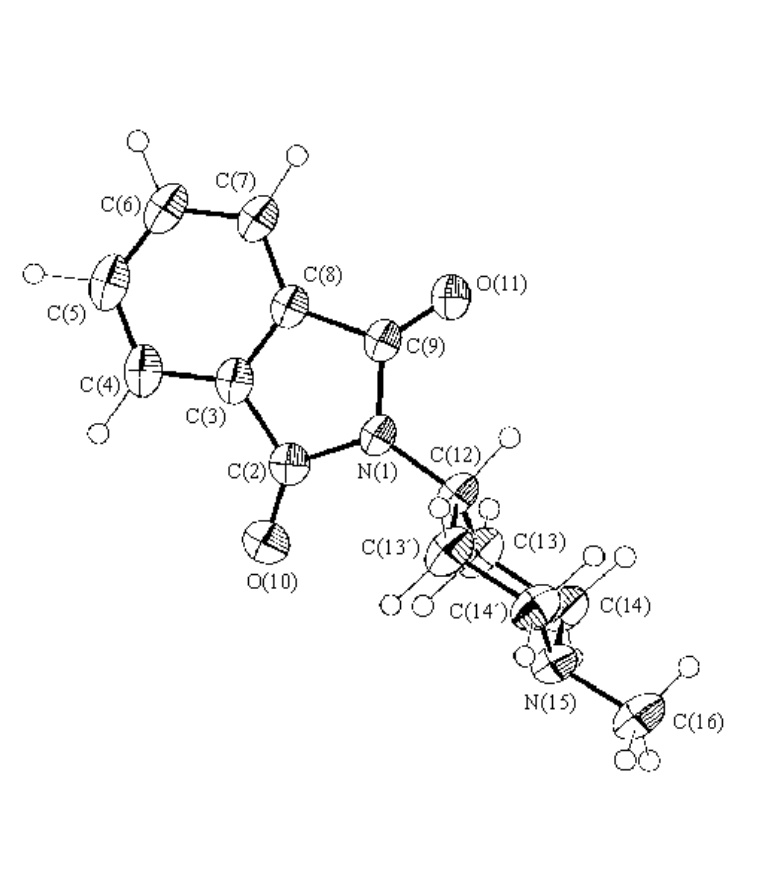
Fig. 4 ORTEP view of compound 1 with the atomic numbering used in the crystallographic study. Displacement ellipsoids are drawn at the 50 % probability